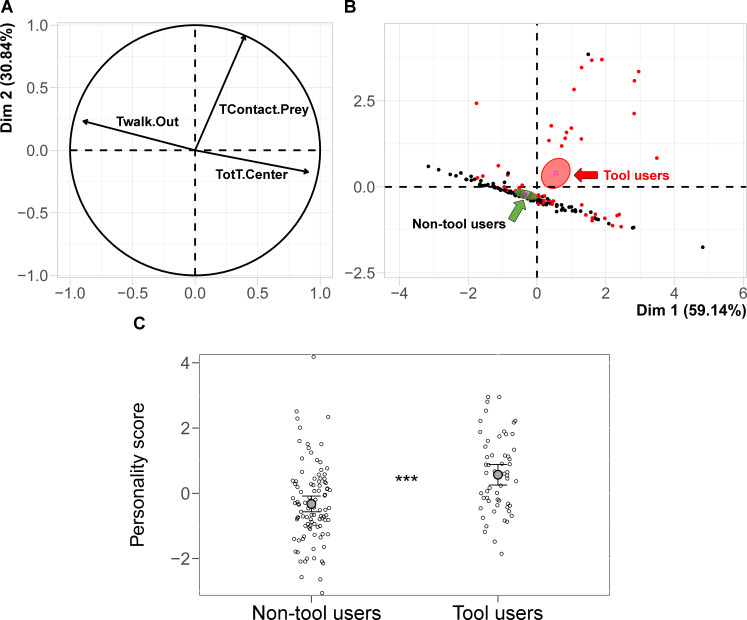
Plots of the first two dimensions of the Principal Component Analysis.Correlation circle of the variables: TWalk.Out (time spent walking in the periphery), TotT.Center (total time spent in the central area); TContact.Prey (time in contact with the prey) (A). Projection of individuals on the PCA factorial space: red dots refer to ants that used tools, black dots refer to ants that did not use tools; the confidence ellipses representing individuals using tools (red arrow) or not (green arrow) show significant difference (no overlap) (B). The probability of using tools is linked to the individual personality score. The mean and CI of the personality score and the individual data points (empty circles) for the non-tool users (mean = −0.33, CI [−0.56,–0.09]) and tool users (mean = 0.57, CI [0.26, 0.88]) is plotted (C). The ants’ personality score significantly predicted the probability of using tools (***: p<0.001).Figure 5—source data 1.Experiment 3 - the variables used in the Principal Component Analysis.A ‘personality score’ for each ant was calculated with a Principal Component Analysis based on (a) total time spent in the central area of the open field, (b) time spent walking in the periphery, (c) time spent in contact with the prey (average of the two sessions for each variable). The figures show the average values of the two sessions used to study the behaviours observed in the two personality tests: open-field and reaction to prey (N = 154). Six ants died between the two sessions of the personality tests, therefore the sample size is 154 ants instead of 160 (20 ants in each of the eight sub-colonies).Figure 5—source data 2.Experiment 3 - the differences in personality score between tool user and non-tool user workers.The personality score of a given ant is represented by its individual value related to the first principal component, accounting for the 59.14% of the total variance, normalised by subtracting the mean value for its colony. The link between personality score and tool use behaviour (tool user or not) was analysed with a GLMM, binomial error structure (logit-link). The ants’ personality score significantly predicted the probability to use tools in at least one trial (N = 154, p<0.001). Six ants died between the two sessions of the personality tests, therefore the sample size is 154 ants instead of 160 (20 ants in each of the eight sub-colonies).